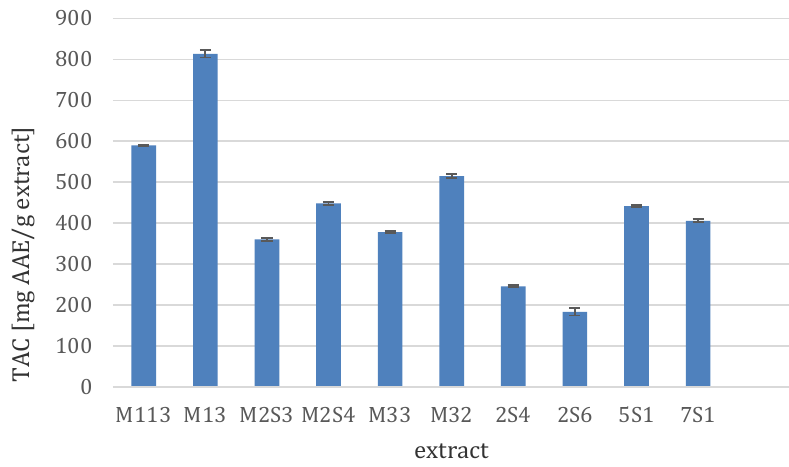
Figure 1. Total antioxidant capacity (TAC) of selected fungal extracts. Results are presented as means ± SD, n = 3) and are expressed as mg ascorbic acid equivalent (AAE)/g extract.